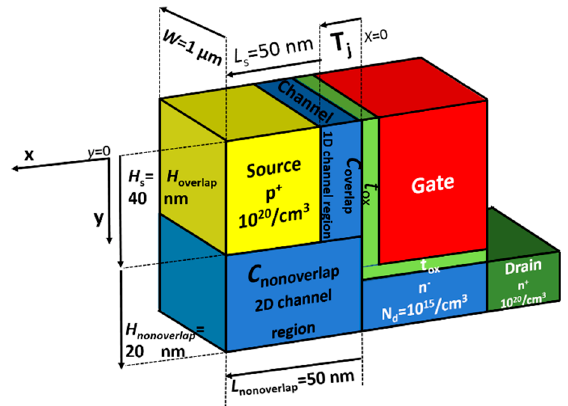
Figure 1. Schematic of the L-shaped tunneling field-effect transistor (LTFET).